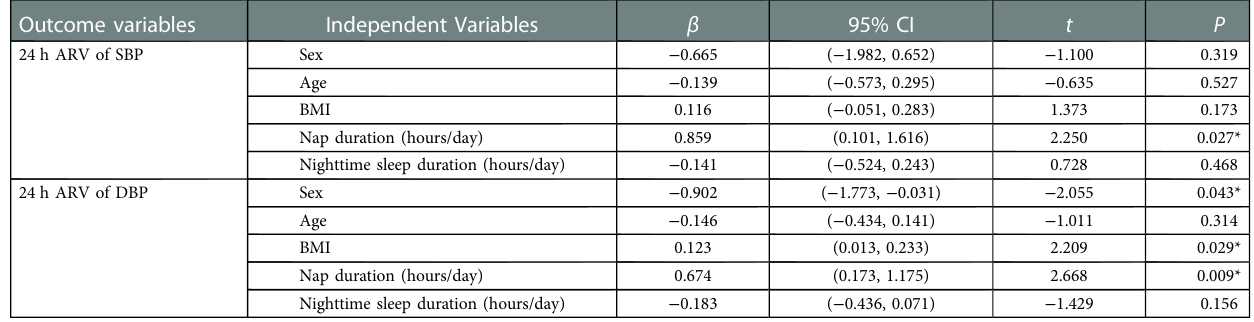
TABLE 4 Multiple linear regression analysis of predictors of ARV. Outcome variables Independent